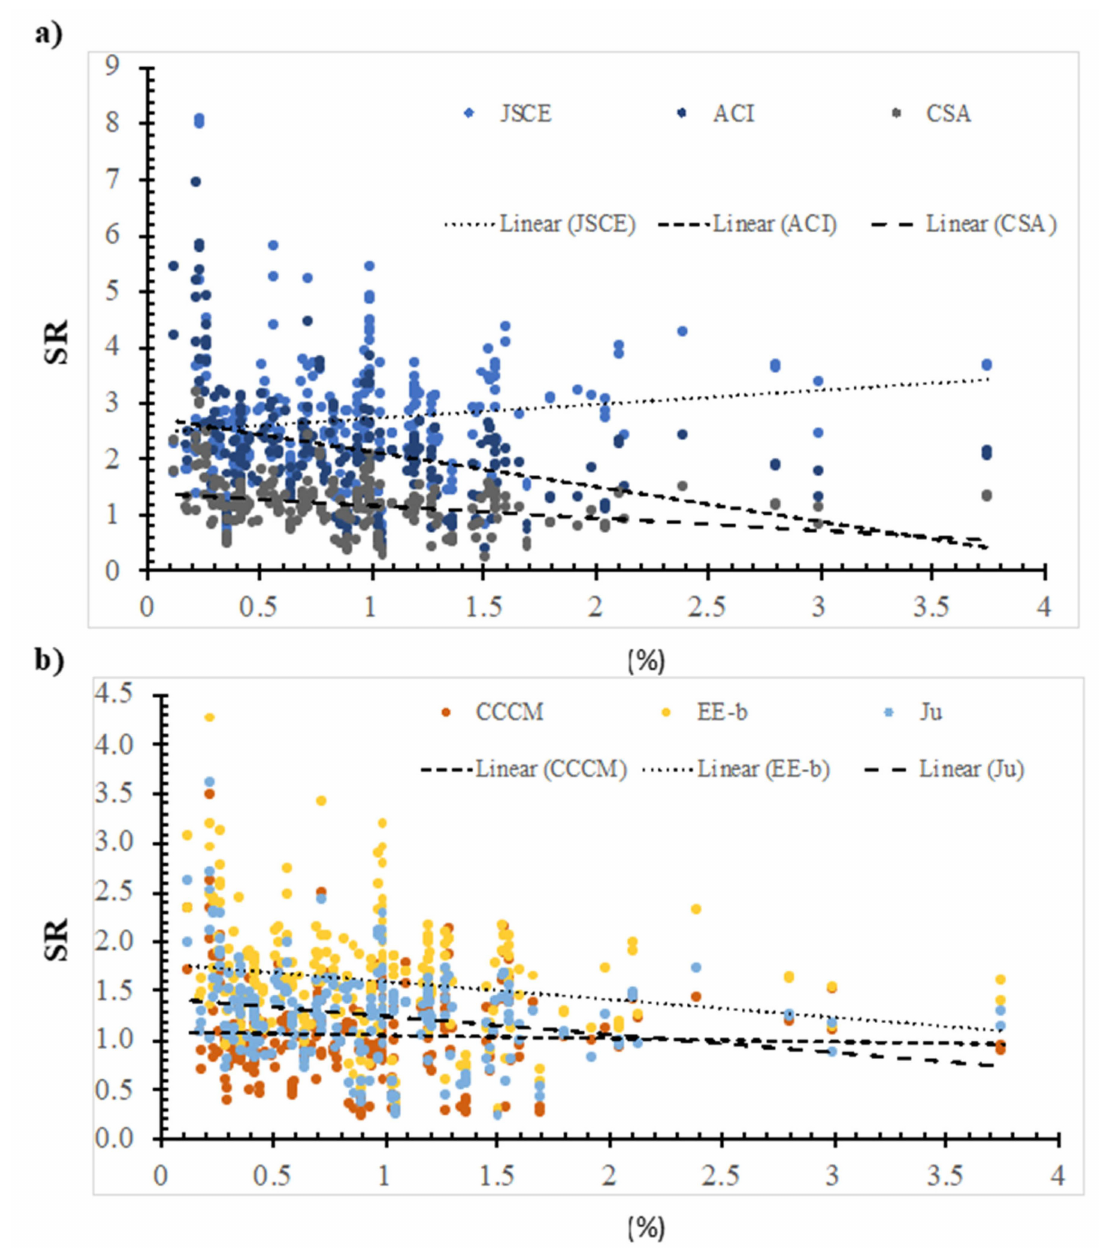
Figure 8. The effect of the flexure reinforcement ratio on the SR value, calculated using selected models. ( a ) Design codes; ( b )